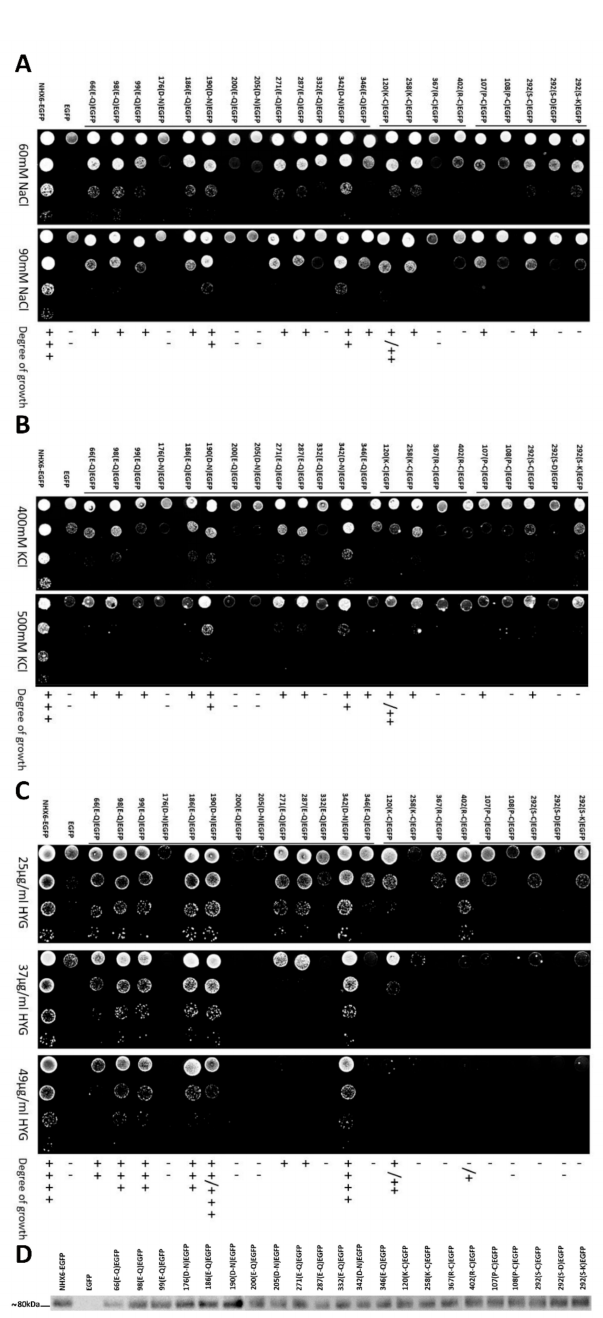
Figure 4. Phenotypic screening of MnNHX6 mutations in yeast. ( A – C ) The full-length MnNHX6 and di ff erent mutations of the MnNHX6 open-reading frame (ORF) without the stop codon were separately fused at the N-terminus of EGFP (pYPGE15-MnNHX6-EGFP). These point mutants of MnNHX6 were introduced into the yeast mutant strain AXT3 . Empty pYPGE15-EGFP and pYPGE15-MnNHX6-EGFP were used as negative and positive controls, respectively. In total, 4 µ L of 10-fold serial dilutions of these strains from saturated cultures were spotted onto AP plates supplemented with di ff erent concentrations of NaCl (60 and 90 mM) ( A ), KCl (400 and 500 mM) ( B ) at pH 5.8 and YPD plates supplemented with hygromycin B (25, 37, and 49 µ g / mL) ( C ). ( D ) Expression levels of the di ff erent mutations of MnNHX6-EGFP (NHX6-EGFP). Microsomal membrane proteins (35 µ g) were separated electrophoretically and subjected to Western blot using anti-GFP antibodies, pYPGE15-MnNHX6-EGFP (NHX6-EGFP) and pYPGE15-EGFP (EGFP) was used as positive and negative control,